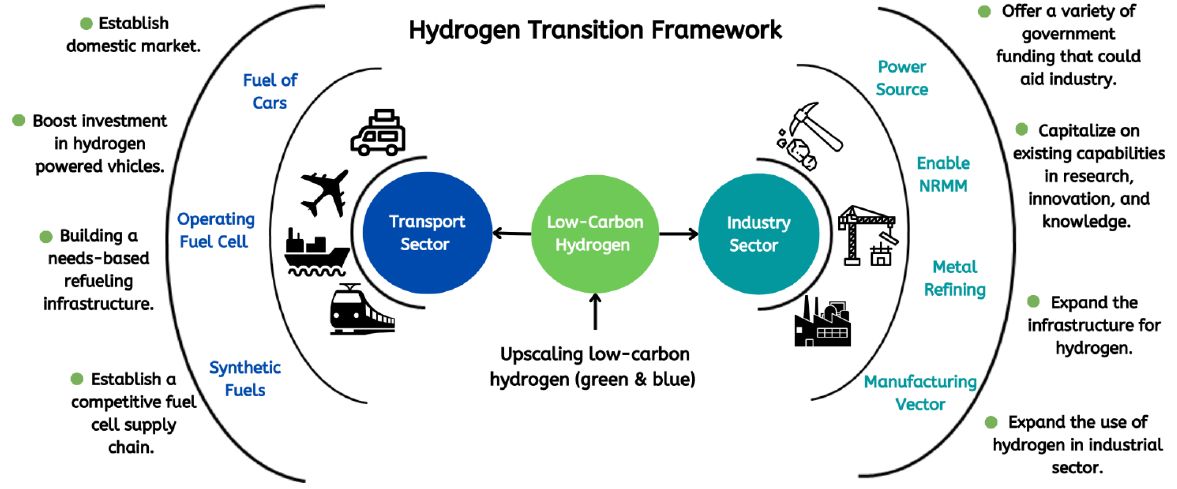
Figure 8. Hydrogen energy transition framework for the UAE’s transportation and industry sec- tors.